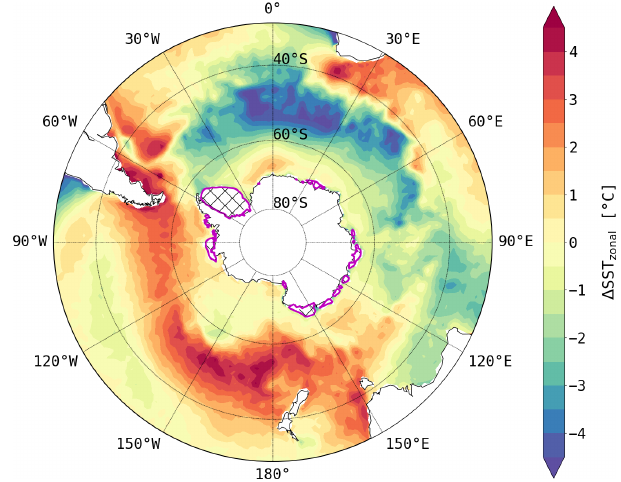
Figure 6. Deviations of the sea surface temperature from the zonal mean from December 2016 to March 2017 using ERA-Interim. Land areas and areas covered by at least 50% sea ice are blanked. Additionally, the blanked sea ice areas are hatched and bounded by pink